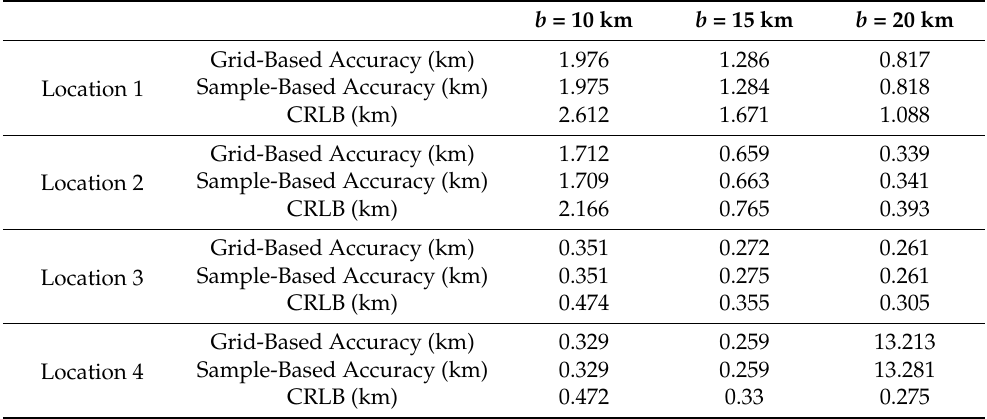
Table 2. Accuracy of grid-based (a grid resolution of 100 m) and sample-based (10 6 samples) solutions vs. the CRLB at the selected four emitter locations with measurement noise of 1 Hz and sensor constant velocity of 150